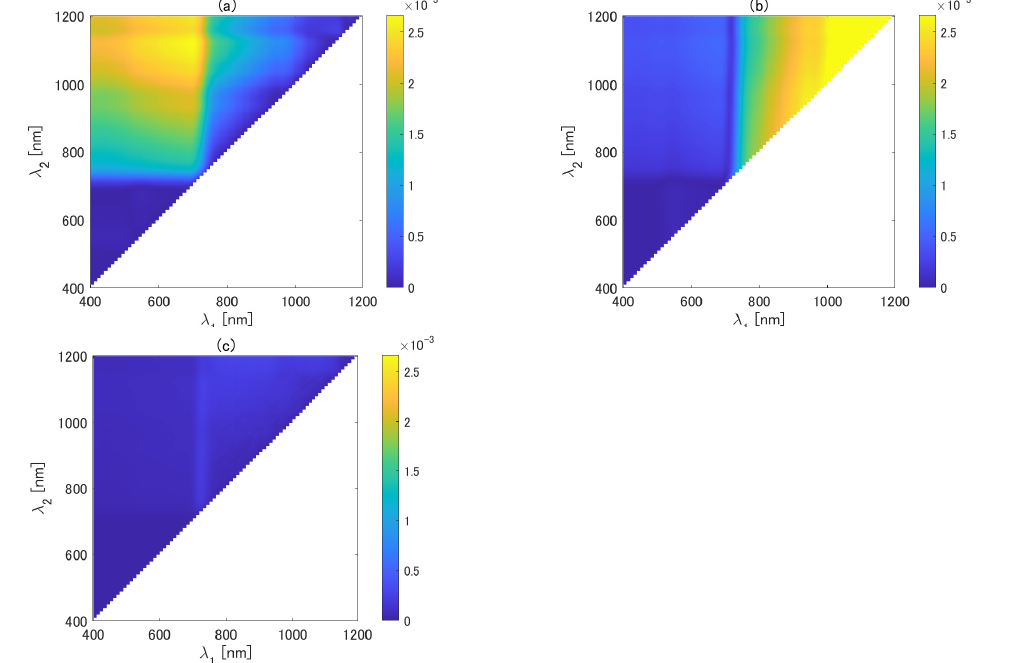
Figure 6. Mean epsilon for ( a ) first-order, ( b ) asymmetric-order, and ( c ) optimized asymmetric-order isoline equations as a function of λ 1 and λ 2